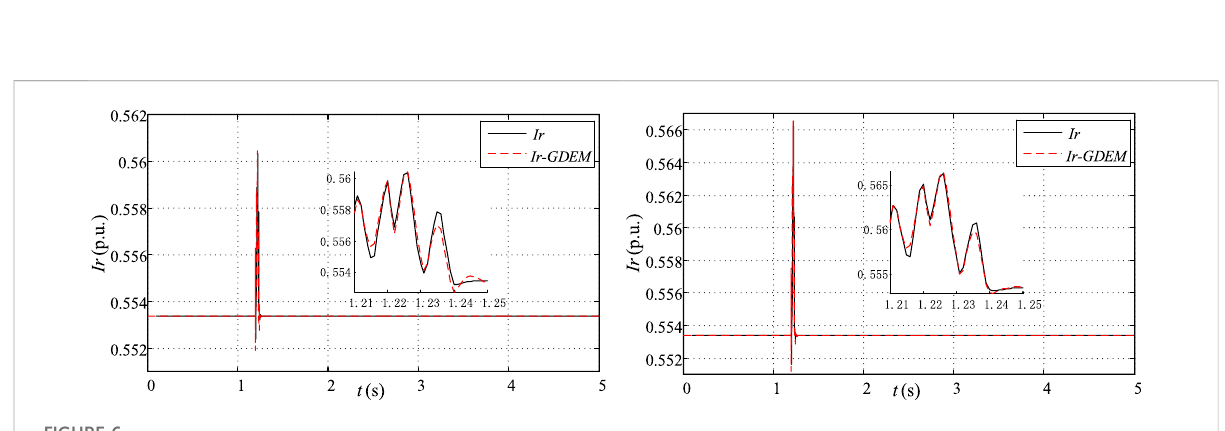
Dynamic characteristic response of the real part of the current with F3 and F4 in operating condition 1.